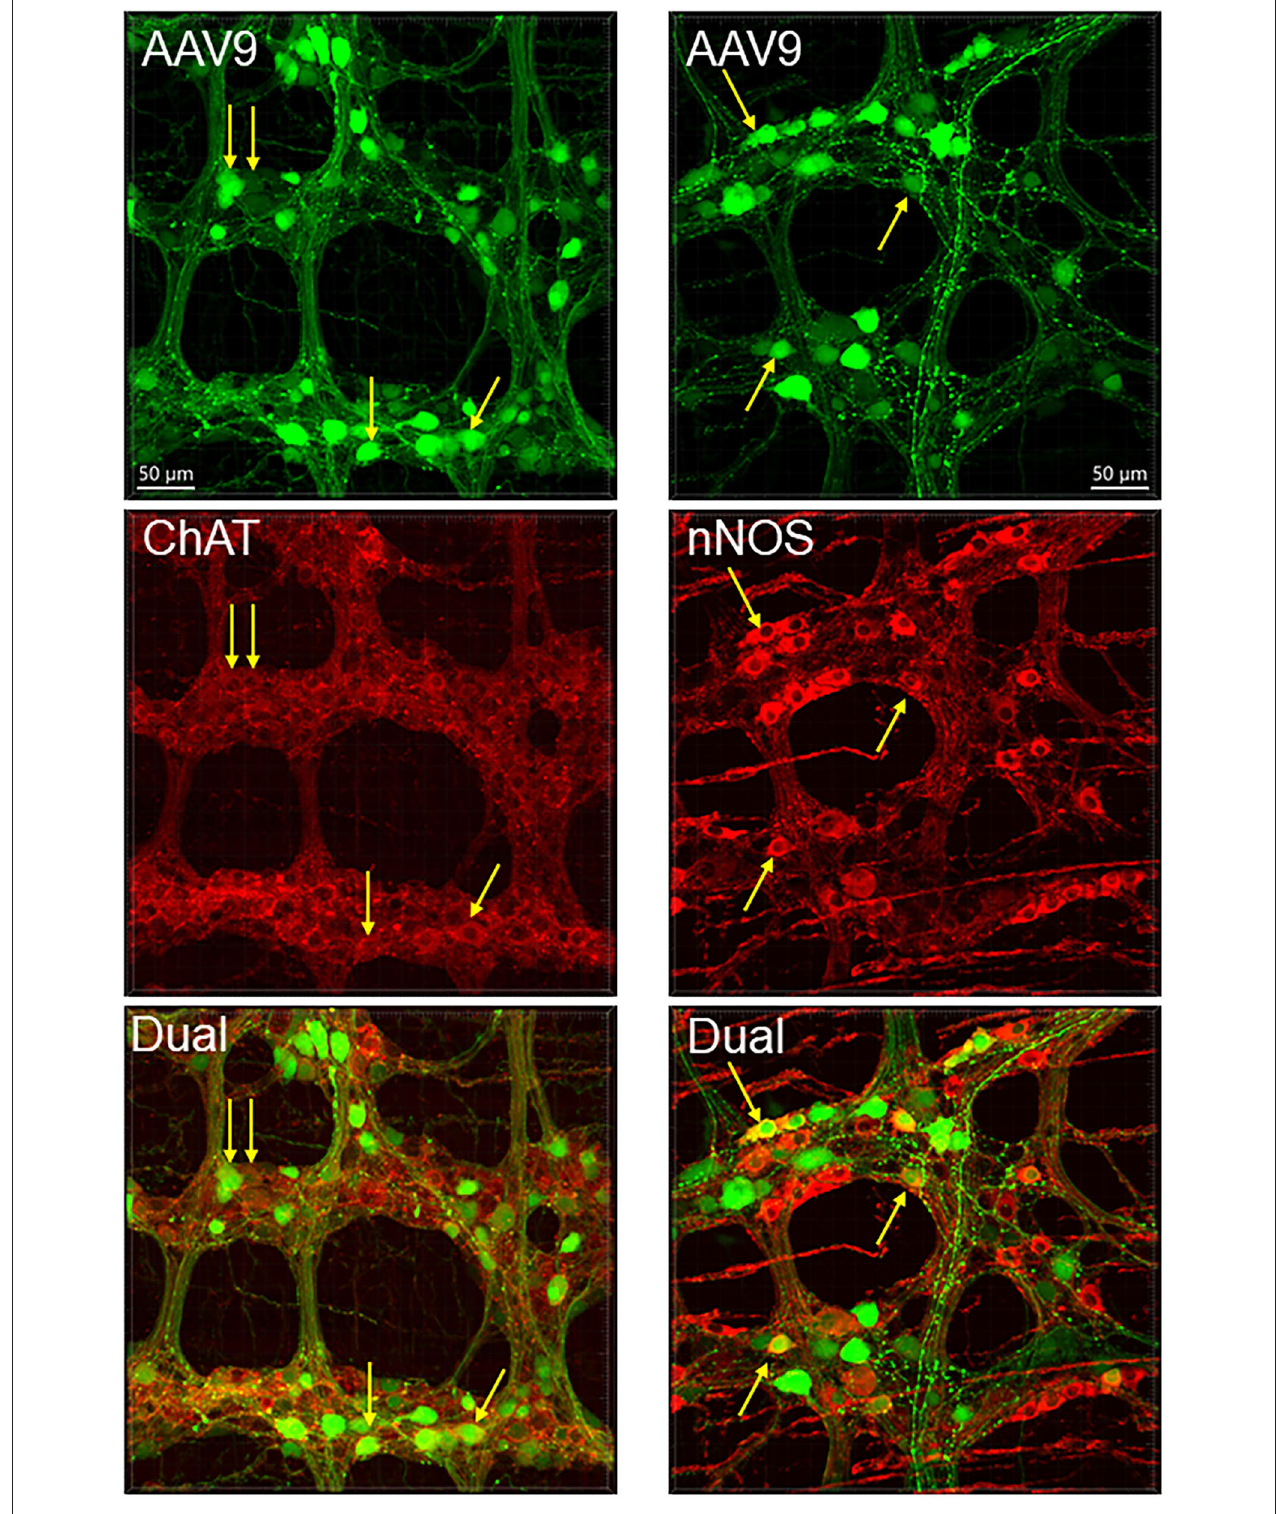
FIGURE 5 | AAV9 transduction in the myenteric plexus whole mount preparations of the mouse proximal colon combined with immunofluorescence of choline acetyl transferase (ChAT) and neuronal nitric oxide synthetase (nNOS). AAV9-CAG-GFP was retro-orbitally injected at 3.3 x 10 11 GC/mouse 3 weeks before. Arrows indicate some of the dual labeled